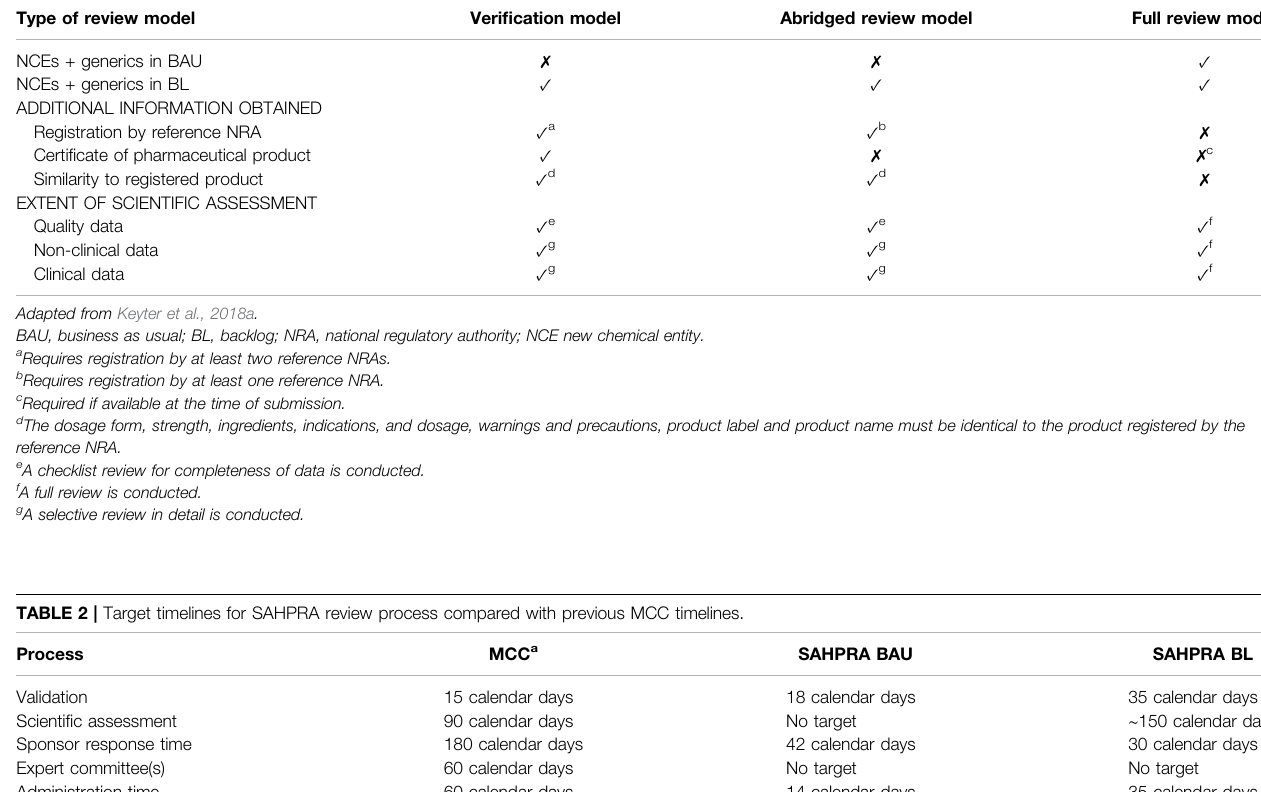
TABLE 1 | Data requirements for the review models and extent of the scienti fi c